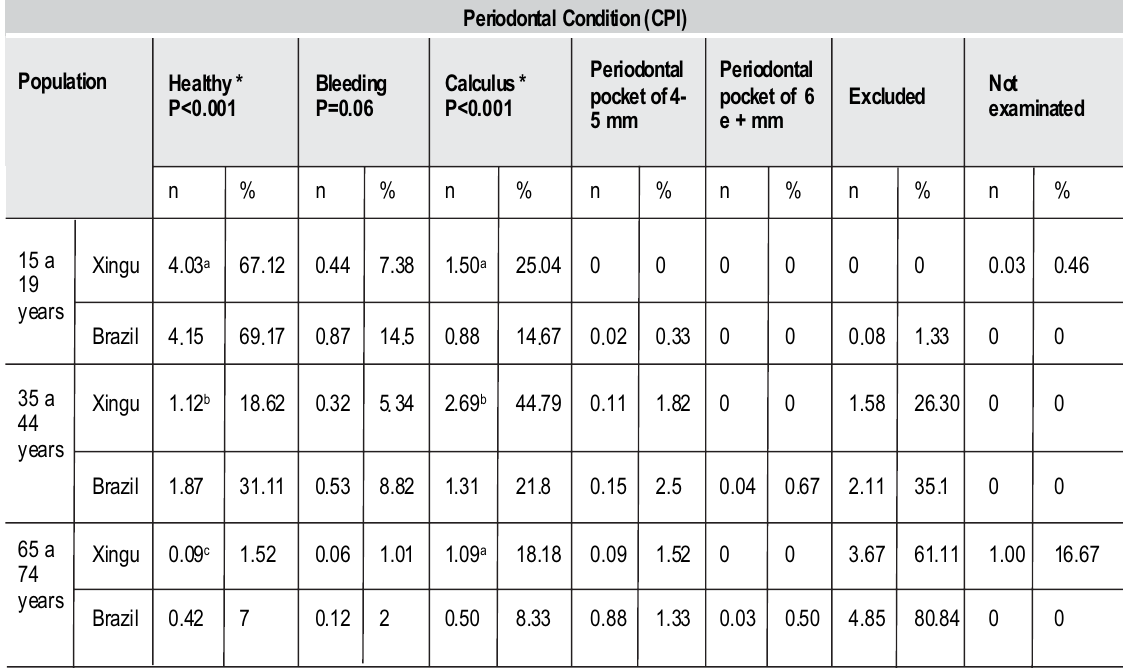
Table 2 - Average number of sextants and the respective shares for each CPI scores according to age and population. Brazil (2004) 4 and Middle and Low Xingu, 2006.